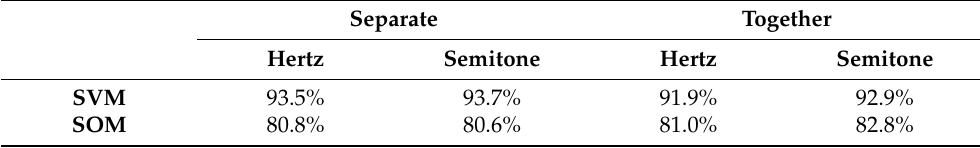
Table 4. Tone recognition rates using two-level abstraction based on SVM and SOM models. Separate Together